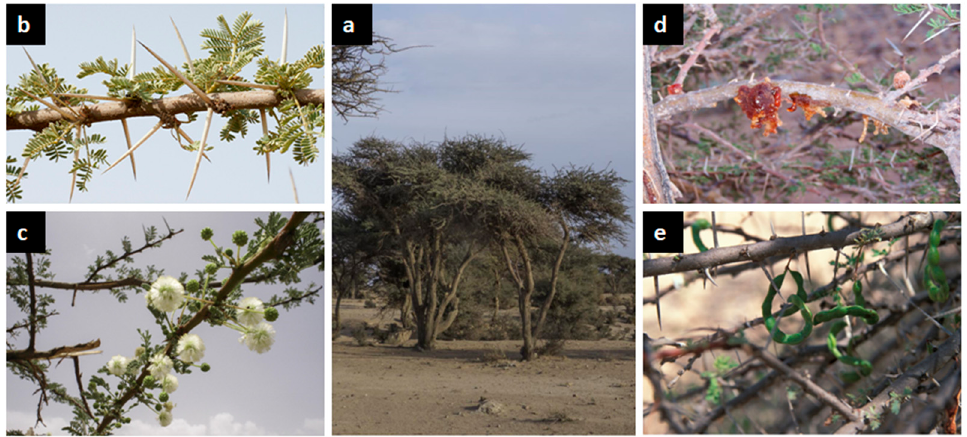
Figure 2. V. tortilis tree general aspect ( a ), leaves ( b ), flowers ( c ), gum ( d ) and pods ( e ) (https://www.teline.fr, accessed on 10 August